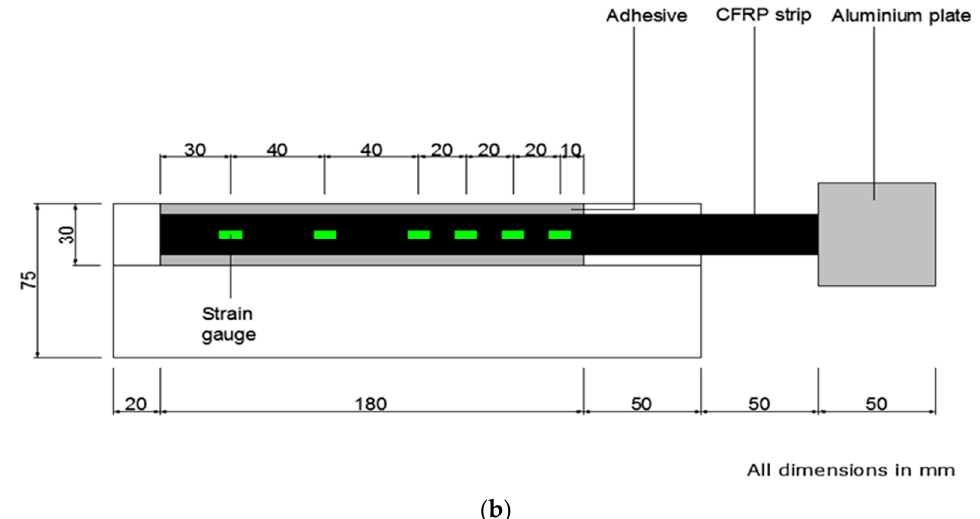
Figure 3. ( a ) Test set-up; ( b ) Strain gauges location.